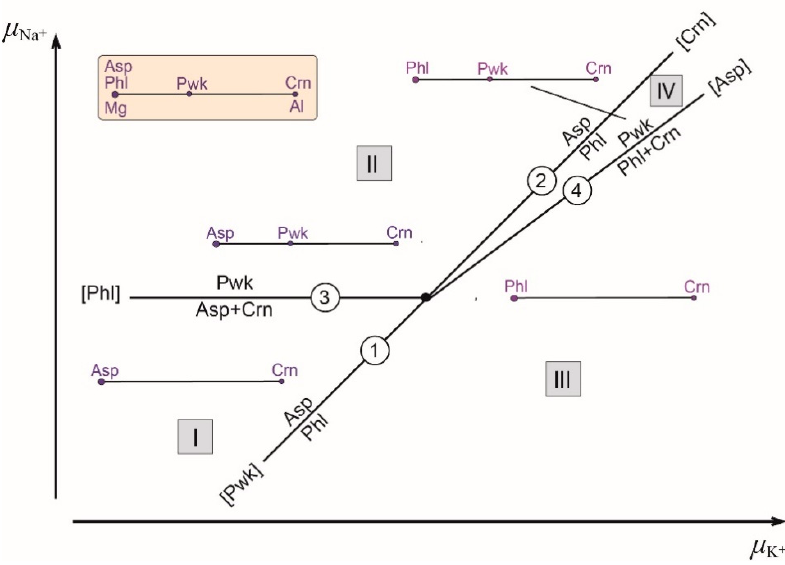
− µ Figure 5. Qualitative 𝜇 (cid:2895) (cid:3126) − 𝜇 (cid:2898)(cid:2911) (cid:3126) diagram of mica parageneses in the system Figure 5. Qualitative µ diagram of mica parageneses in the system K-Na-Mg-Al-Si-H 2 O. I, K + Na + K-Na-Mg-Al-Si-H 2 O. I, II, III, IV—stable divariant fields; the numbers in circles indicate the reac- II, III, IV—stable divariant fields; the numbers in circles indicate the reaction numbers in the Table tion numbers in the Table 4.